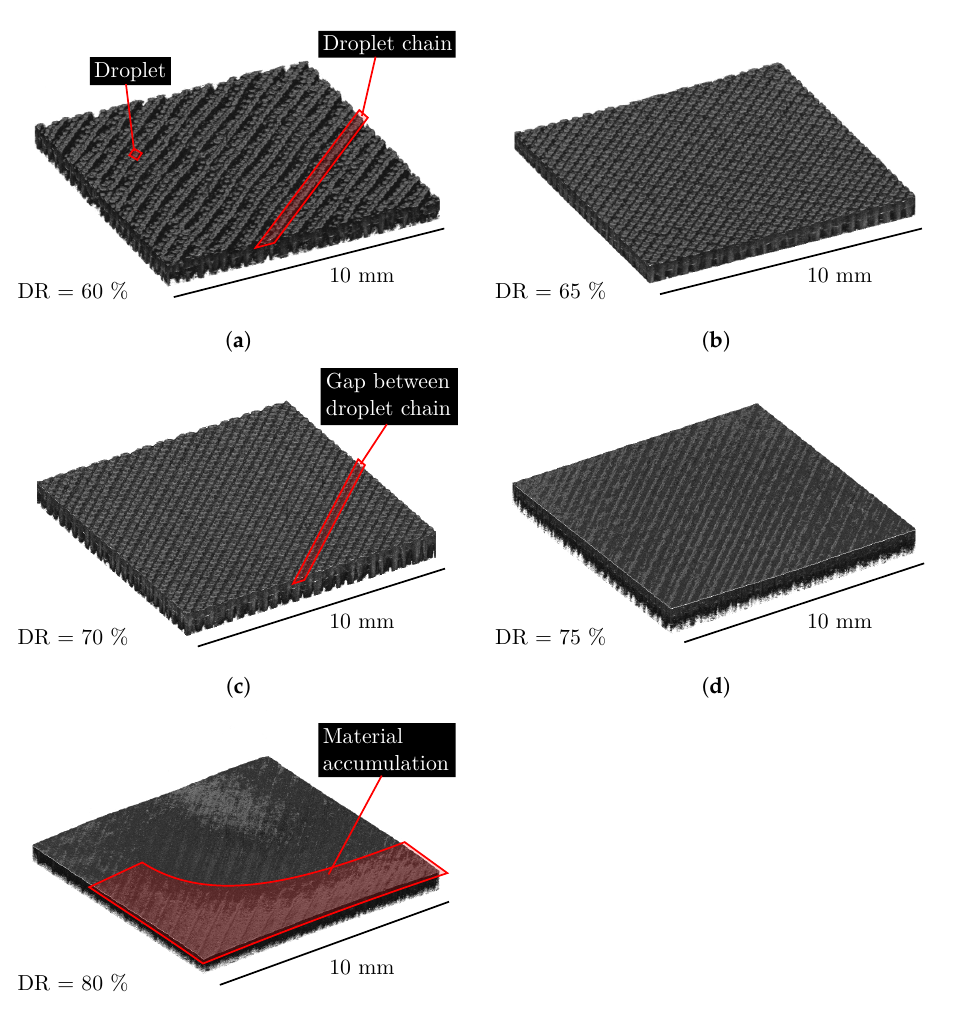
Figure 4. The 3D reconstructions of the surface structure from the top surface of the LT-DAR combination LT200DAR14. DR is varied between the individual 3D reconstructions. Depending on the degree of filling, the individual droplets and droplet chains are visible. ( a – e ): The five different DR